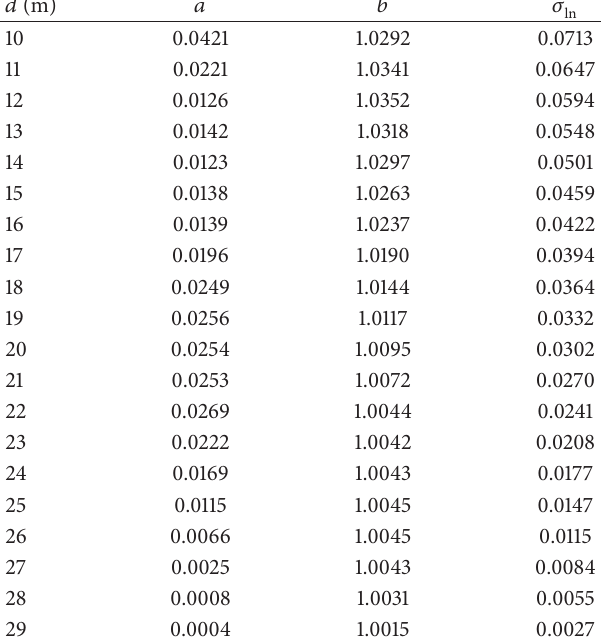
Table 2: Coefficients of (4) for 135 California profiles